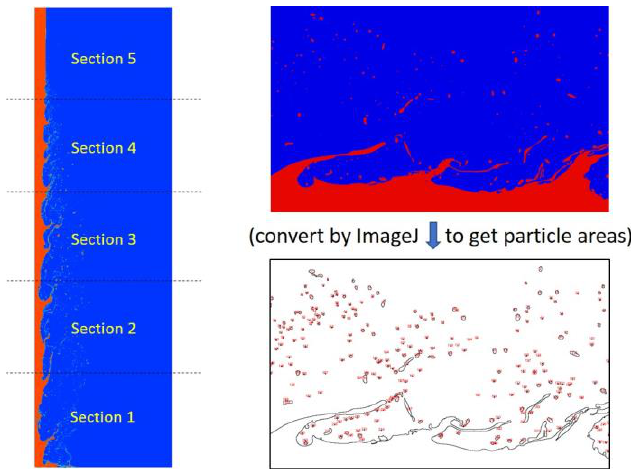
Figure 4. Illustration of jet breakup by KHI and BLS.